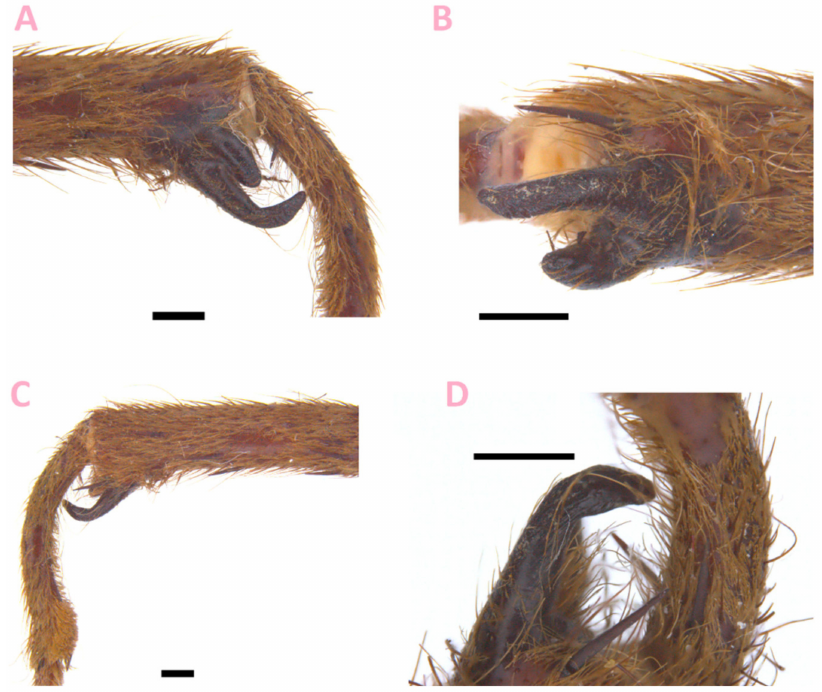
Figure 2. Thrixopelma nadineae sp. nov. holotype male (ZMH-0000888), tibial apophysis (left hand side), ( A ) prolateral view, ( B ) ventral view, ( C ) retrolateral view, ( D ) retro-ventral view. Scale bars = 1